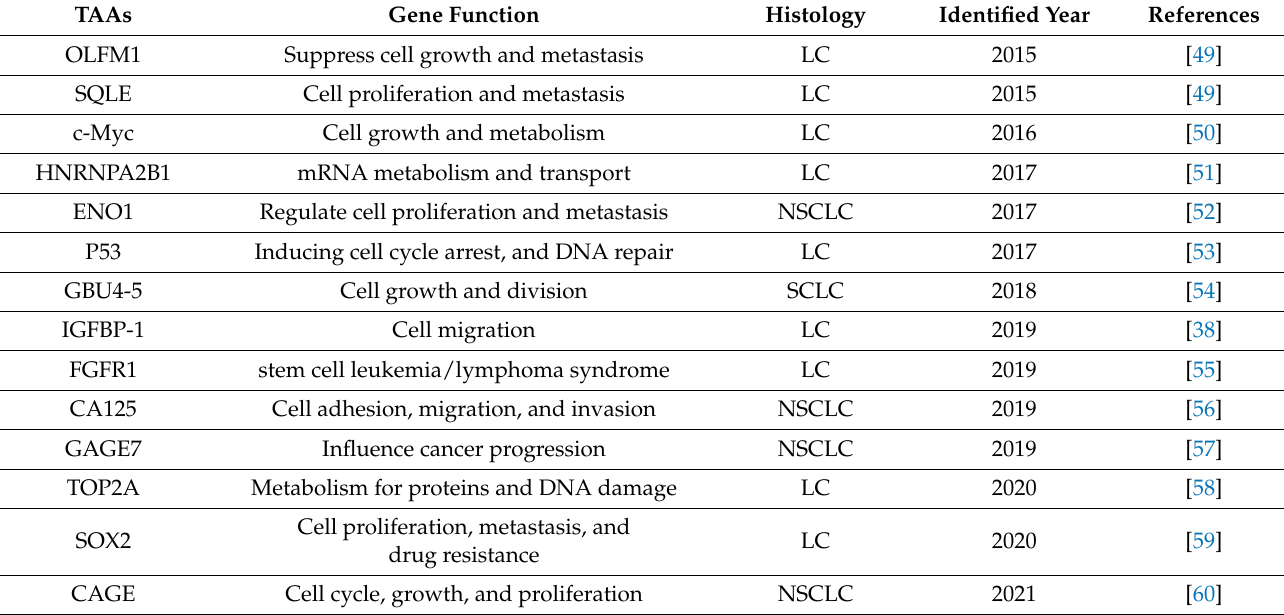
Table 2. Potential TAAs identified in lung